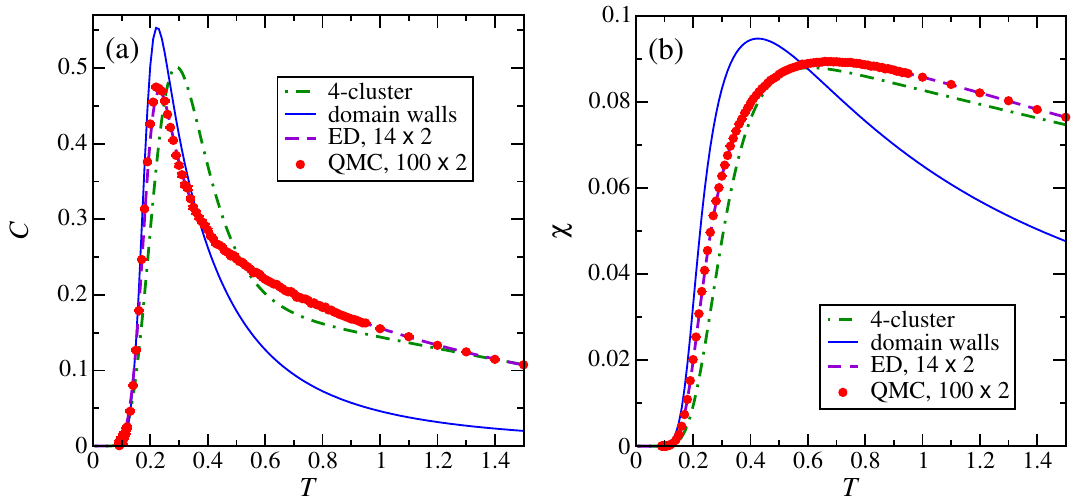
Figure 5: Magnetic specific heat, C (left panel), and susceptibility, χ (right panel), shown per spin for a fully frustrated ladder with rung coupling J ⊥ = 1.45 and inter-rung couplings J × = J (cid:107) = 1. We compare QMC results obtained for a ladder of L = 100 rungs with ED results for L = 14 and with approximate calculations based on clusters of 4 rungs and on a model of non-interacting domain